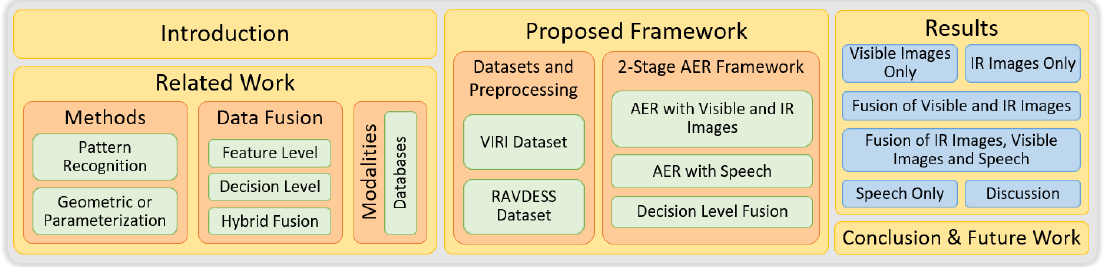
Figure 1. Research paper